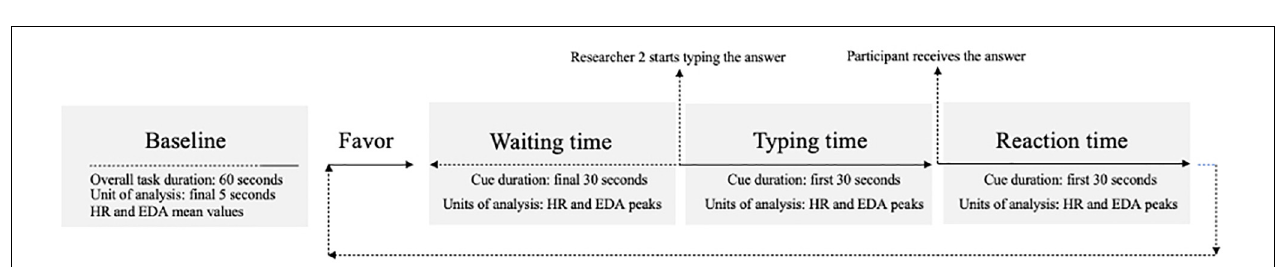
FIGURE 2 | Timeline of experimental task with measurement occasions for Baseline, Waiting time, Typing time, and Reaction